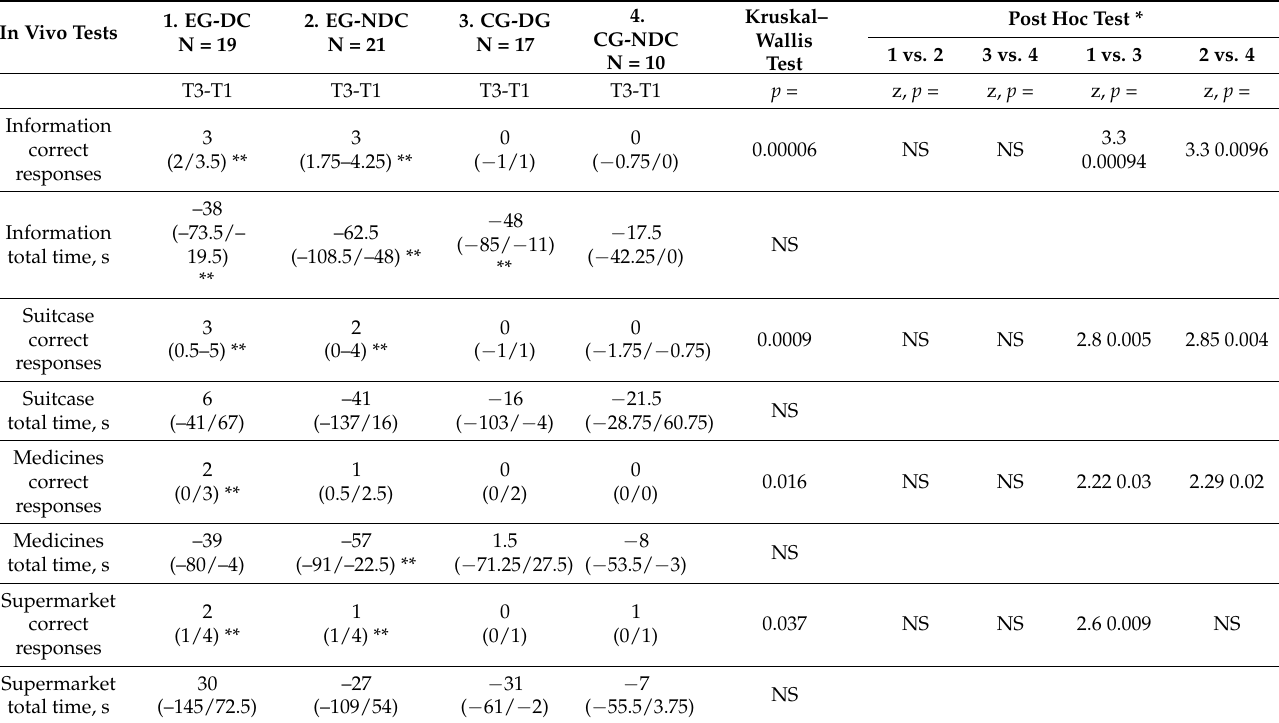
Table 2. Differences between the second (T3) and first (T1) in vivo tests in the degenerative and non-degenerative conditions of EG and CG, and results of the comparisons between the groups. All values are expressed as the median (interquartile range).